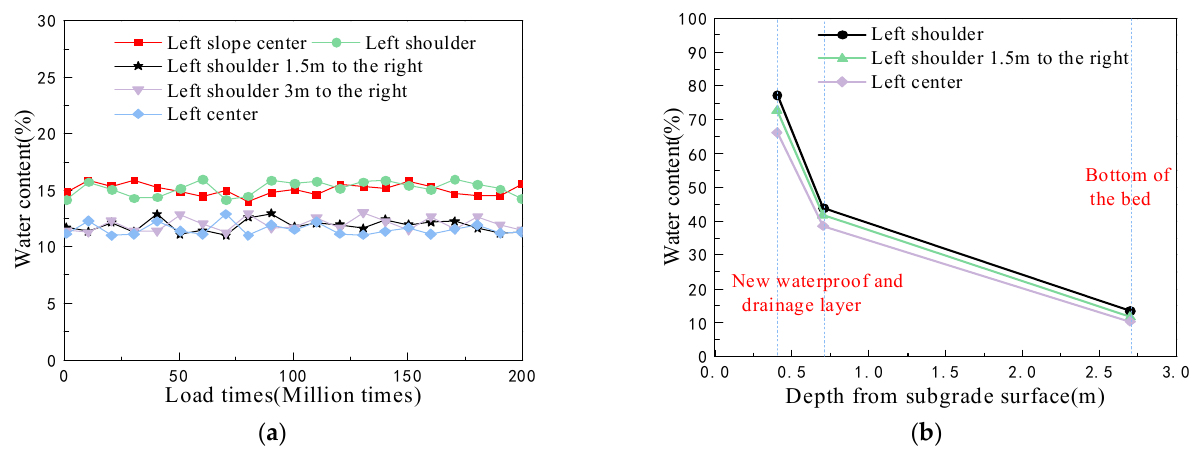
Figure 11. Variations of water content during the excitation test: ( a ) change in the water content at the bottom of the bed; and ( b ) change in the water content in the subgrade as a function of depth.